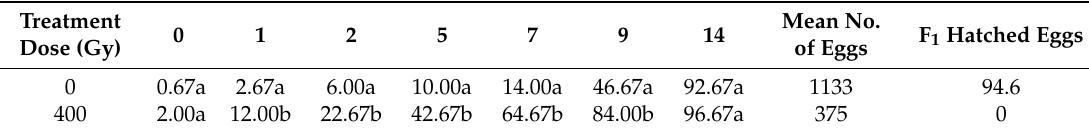
Table 1. F 1 fecundity (no. of eggs), percent of egg hatch and mortality of adult P. citri irradiated with Co 60 γ